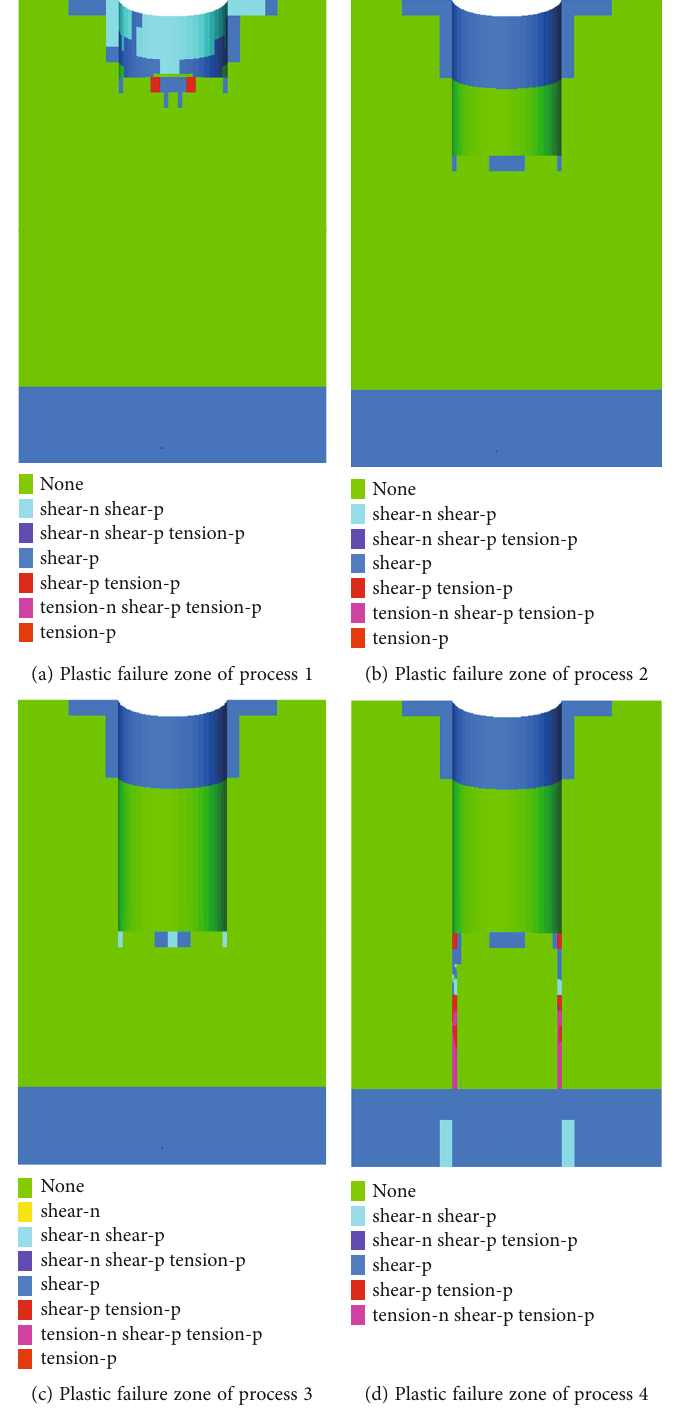
Figure 11: Plastic failure zone